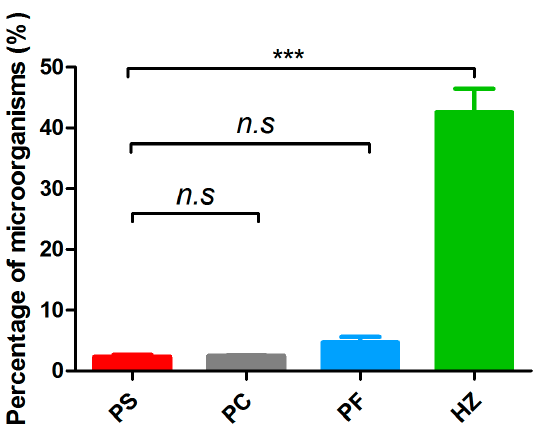
Figure 1. The proportion of sequences belonging to microorganisms in the metagenomic libraries. Significant differences ( p < 0.001) across samples are indicated with “***”. “n.s”, not significant. PS, DNA was extracted directly with PowerSoil DNA extraction kit; PC, DNA was extracted with PowerSoil DNA extraction kit after differential centrifugation; PF, DNA was extracted with PowerSoil DNA extraction kit after filtration; HZ, DNA was extracted directly with HostZERO microbial DNA kit.